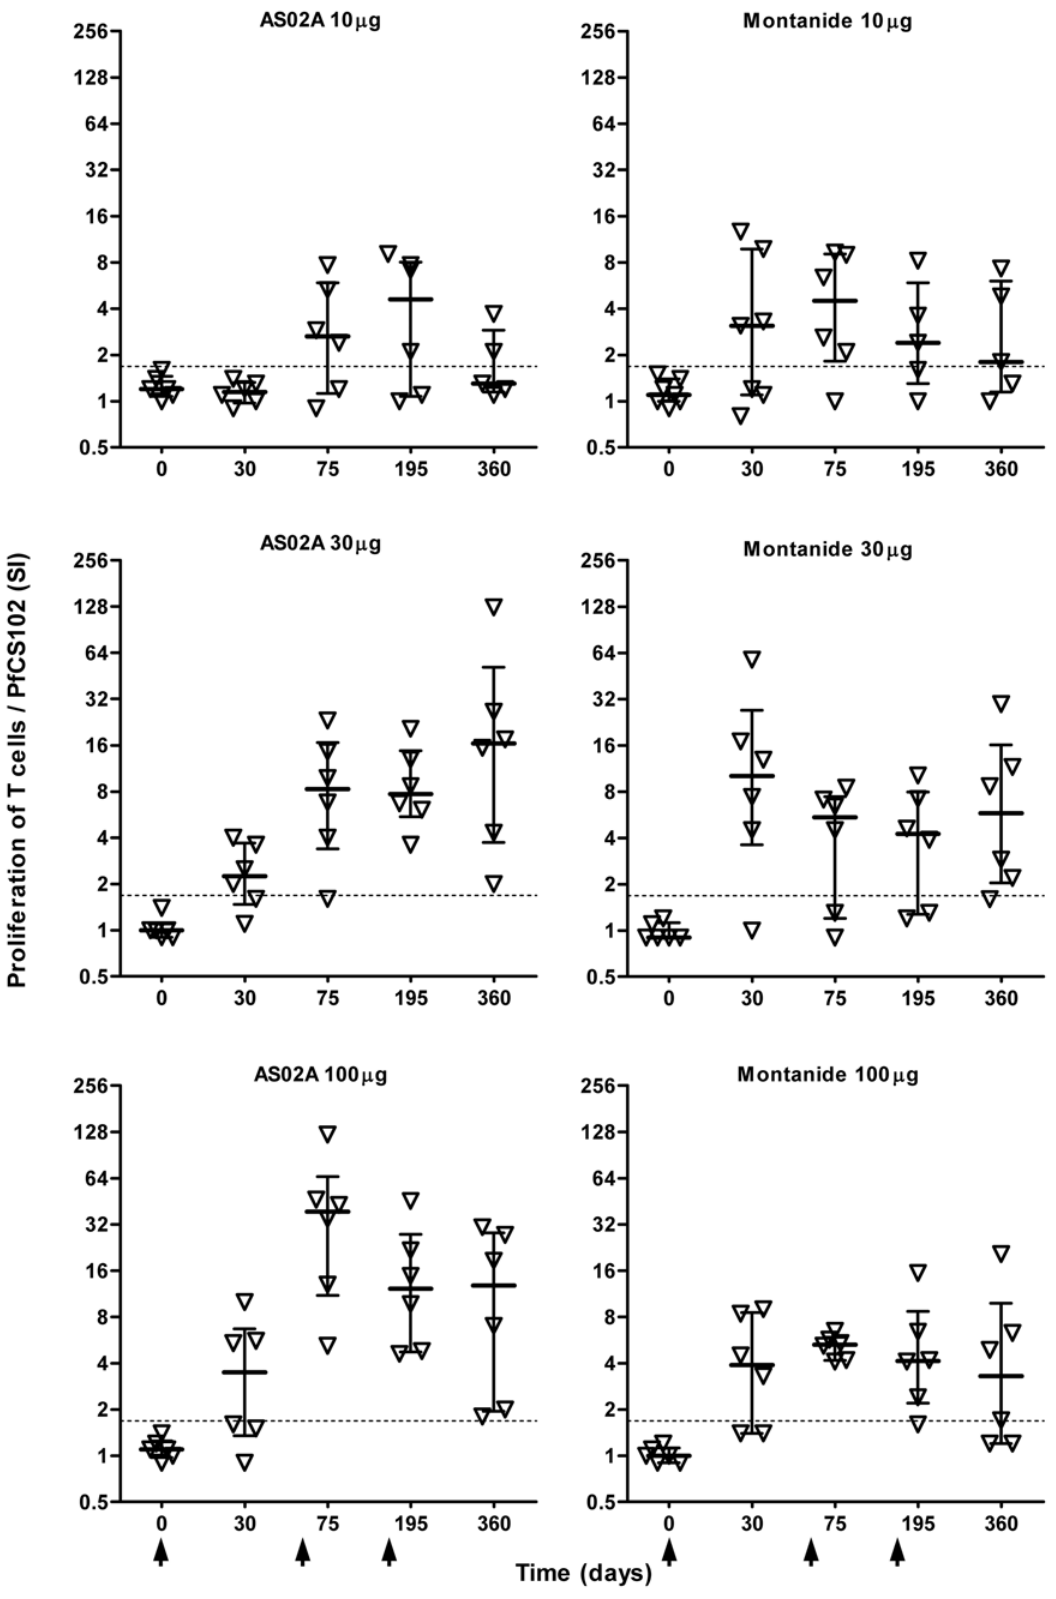
Figure 4. Time-course of anti-PfCS102 proliferative T cell response. Proliferative responses were evaluated by 3 [H]-thymidine incorporation by peripheral blood mononuclear cells (PBMC) upon stimulation with antigen. Results are expressed as individual stimulation indices (SI) in each immunization group with quartiles. Arrows indicate the times of vaccination.